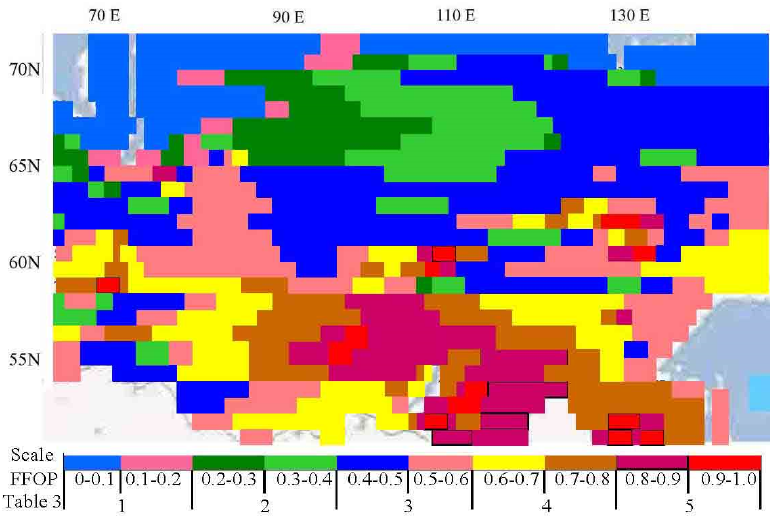
Figure 10. Spatial distribution of FFOP as well as the fire risk and hazard levels in Siberia on 20 July 2019.